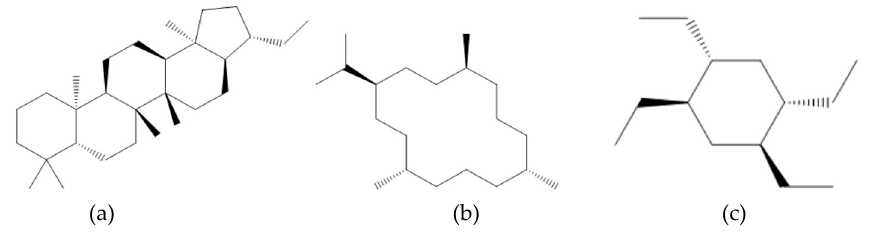
Figure 6. The structure of ( a ) 28-Nor-17 alpha (H)-hopane; ( b ) Cembrane; and ( c ) 1,2,4,5-Tetraethyl- cyclohexane.